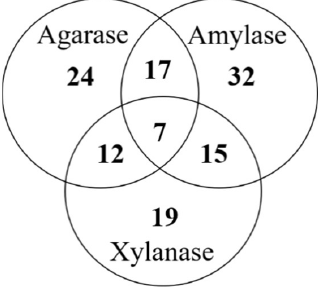
Figure 1. Enzyme activities of 78 isolated bacterial strains.